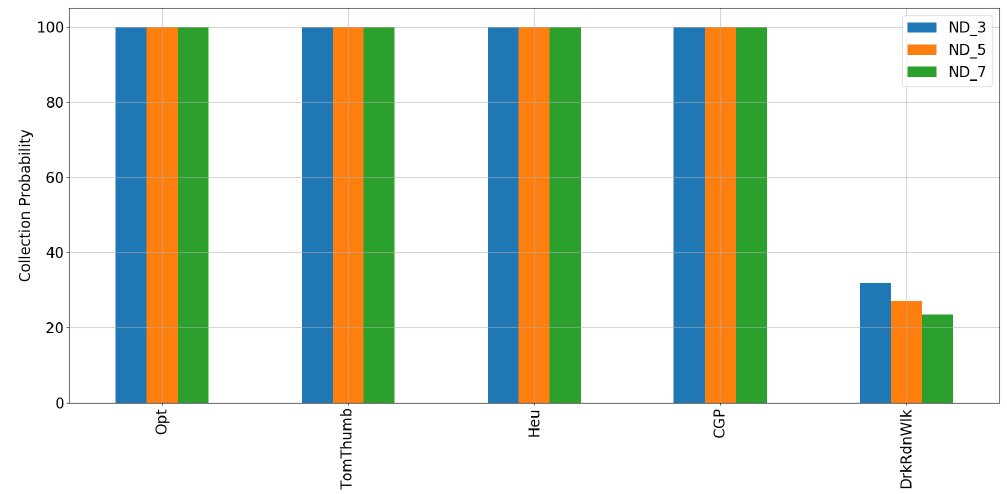
Figure 8. Collection probability comparisons among the proposed TT and alternative approaches for Scenario 1 and different ND